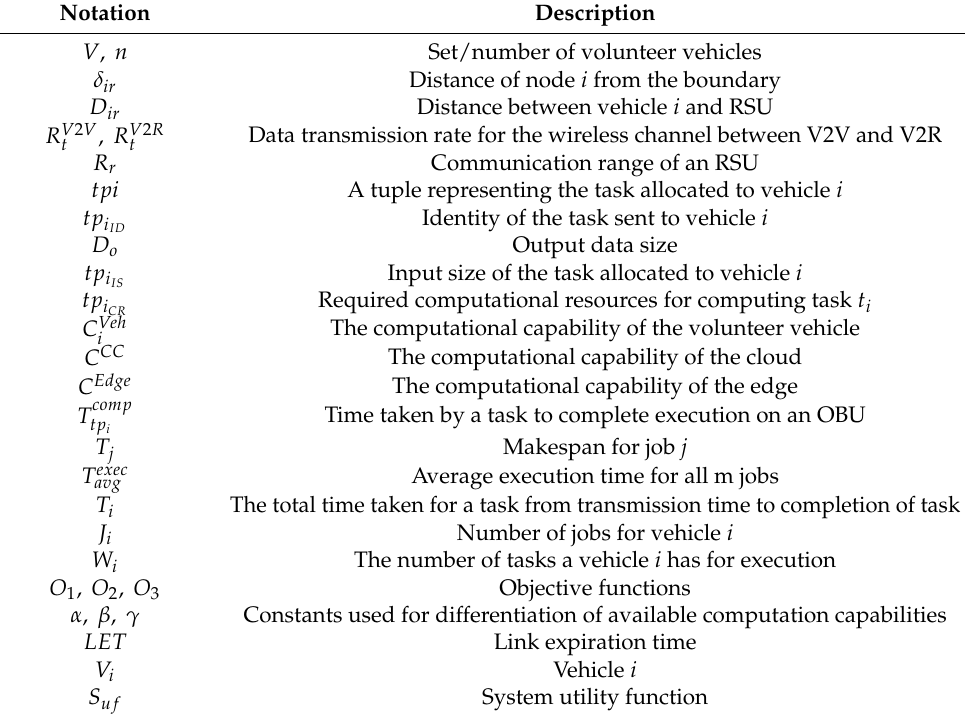
Table 1. List of